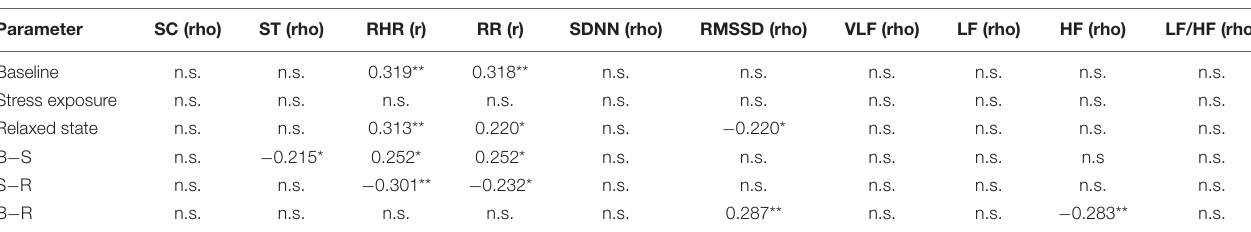
TABLE 5 | Diastolic blood pressure and electrophysiological parameters. Parameter SC (rho) ST (rho) LF/HF (rho) Baseline Stress exposure n.s. Relaxed